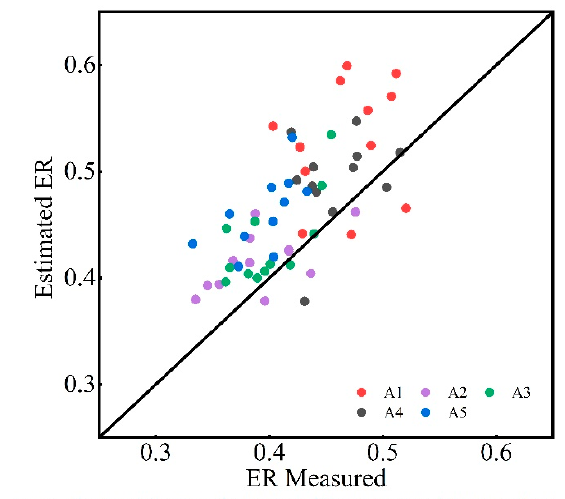
Figure 13. TLS data to estimate di ff erent cultivars at plot-scale ER at the fi lling period in 2019.